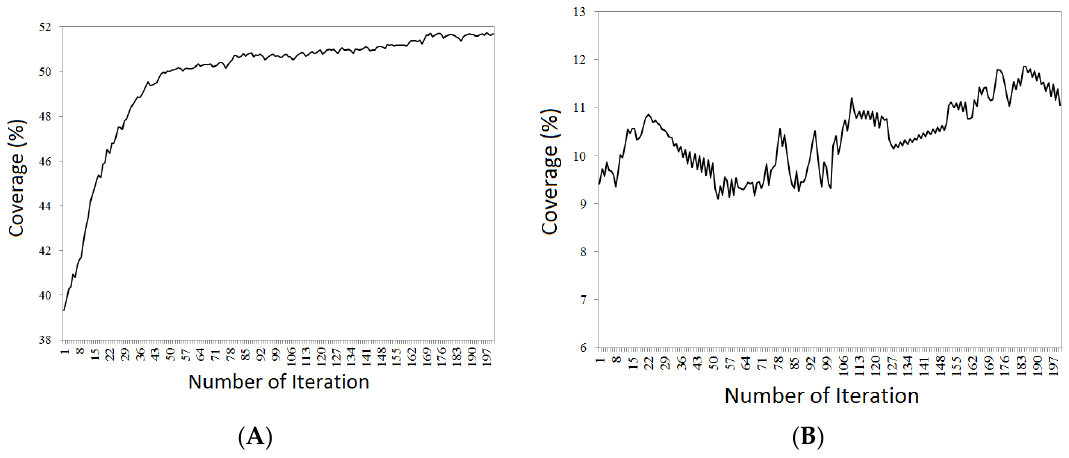
Figure 14. Convergence diagram of probability coverage based on L-BFGS algorithm for: ( A ) two-dimensional; and ( B ) three-dimensional raster models.